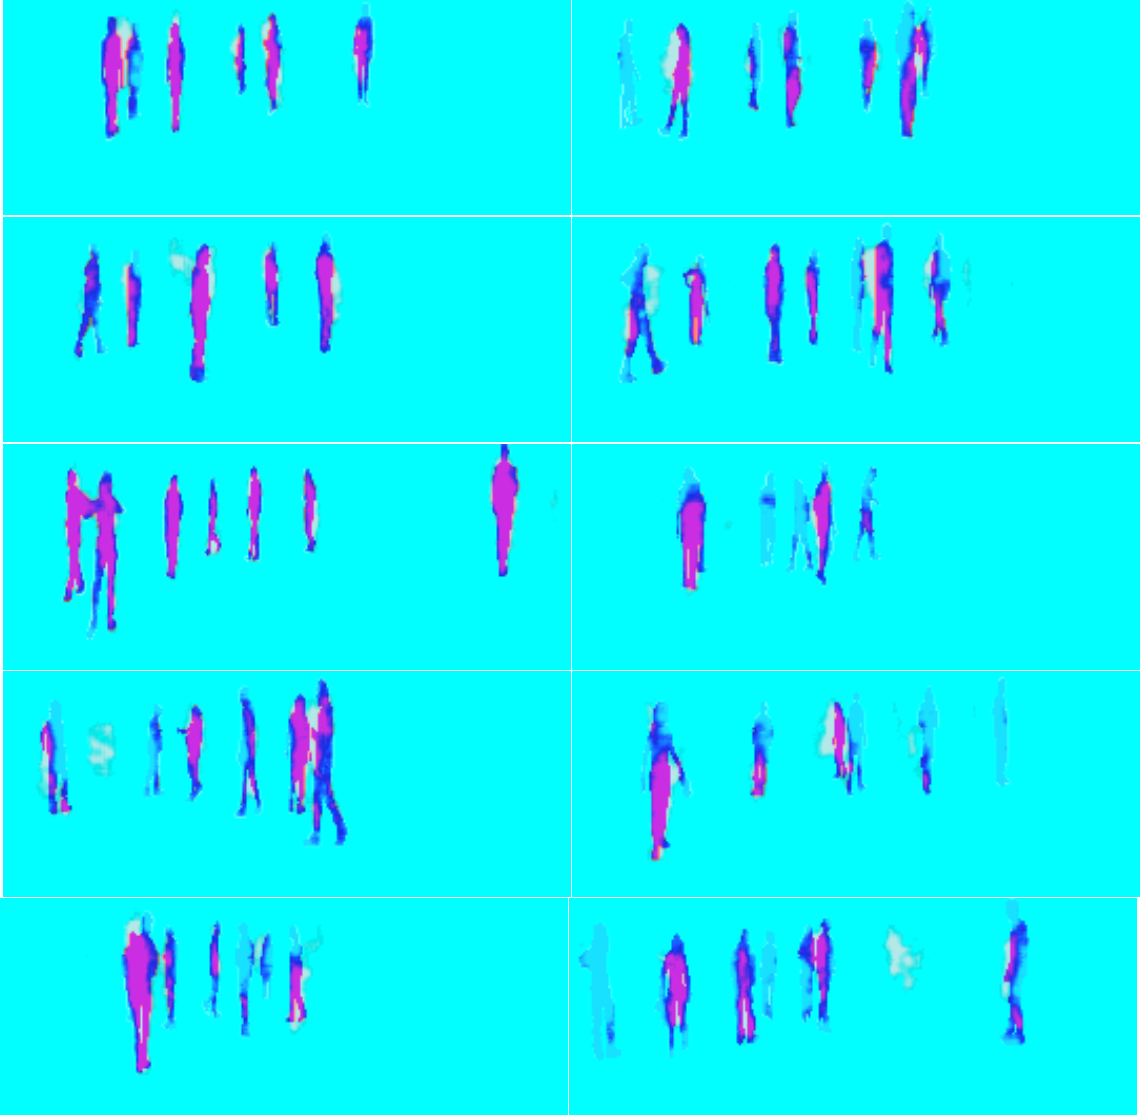
Figure 25. The figure displays in red the overlapping area between the ground truth and the model’s output. The ground truth is depicted in blue, and the white spots are part of the model’s output but do not overlap. The weak blue light over the pedestrians indicates a very weak detection by the model due to its